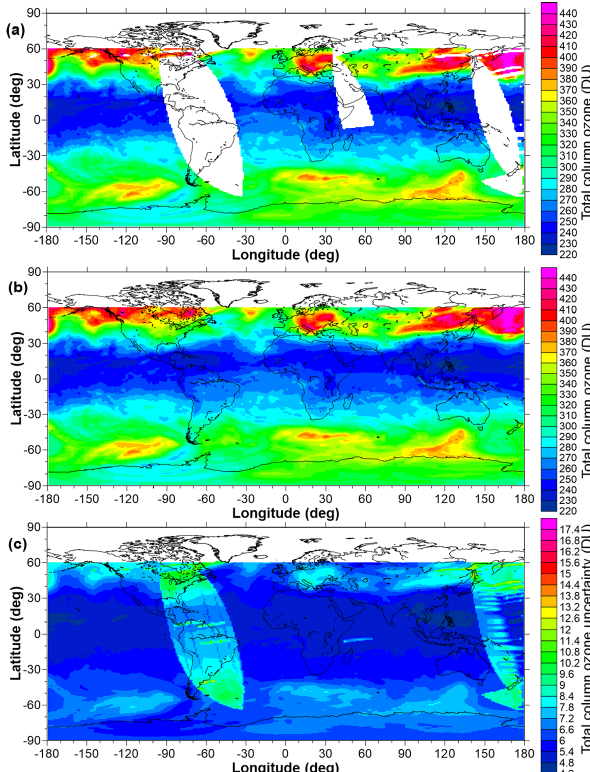
Figure 13. (a) The original unfilled TCO field on 3 January 1980, (b) the conservatively filled TCO field on the same day, and (c) the uncertainties on the conservatively filled field. White regions show where data are